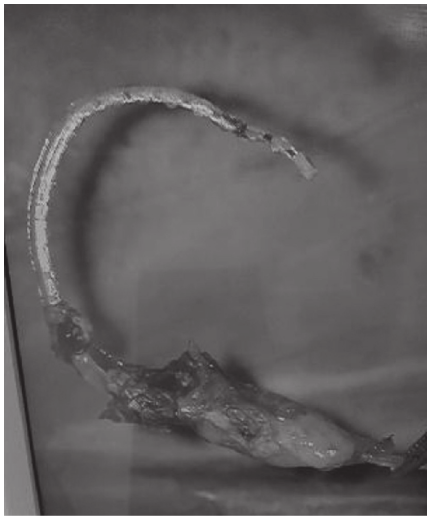
Figure 3: Cholesteatoma diseased tissue embedding a part of the electrode array.